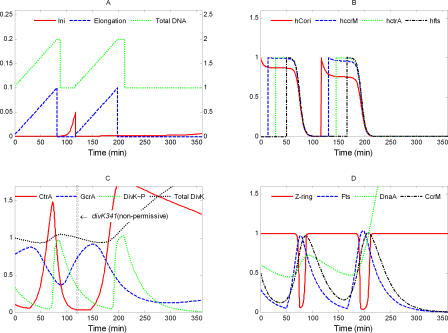
Simulation of divK341cs: k
d,ctrA2 = 0